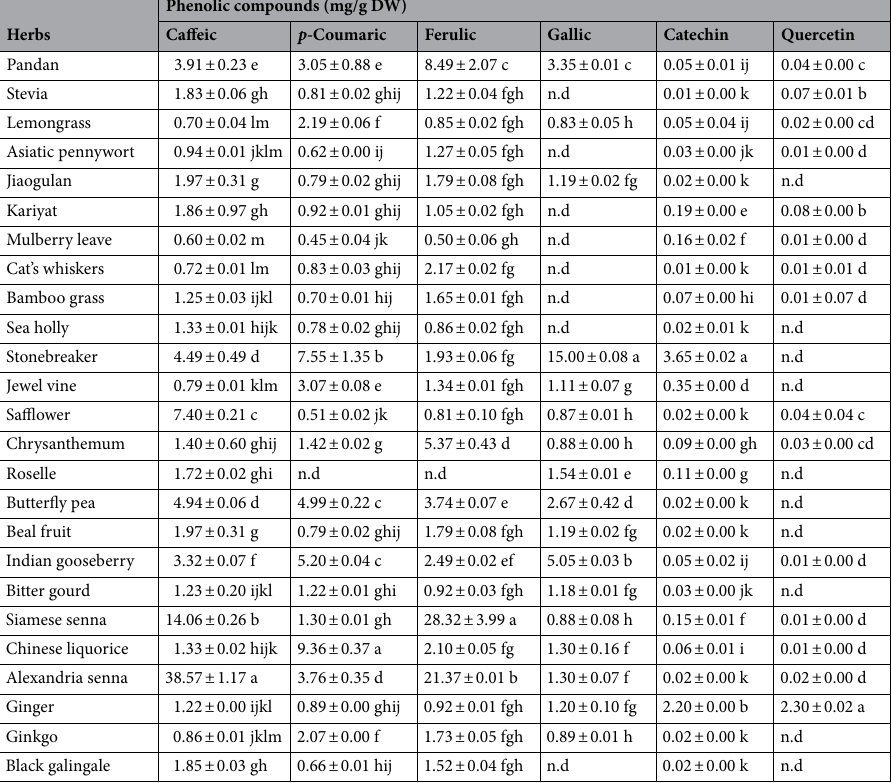
Table 2. The contents of phenolic compounds of dried herbal plant extracts. Values are means ± SD of three measurements (n = 3). n.d. = not detected. Means in columns with superscript letters indicate significant differences ( p <